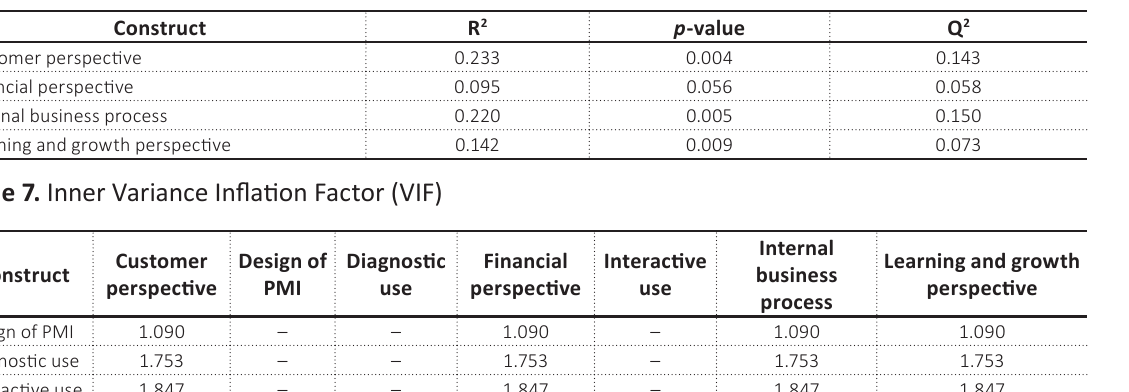
Table 6. Coefficient of determination and predictive relevance